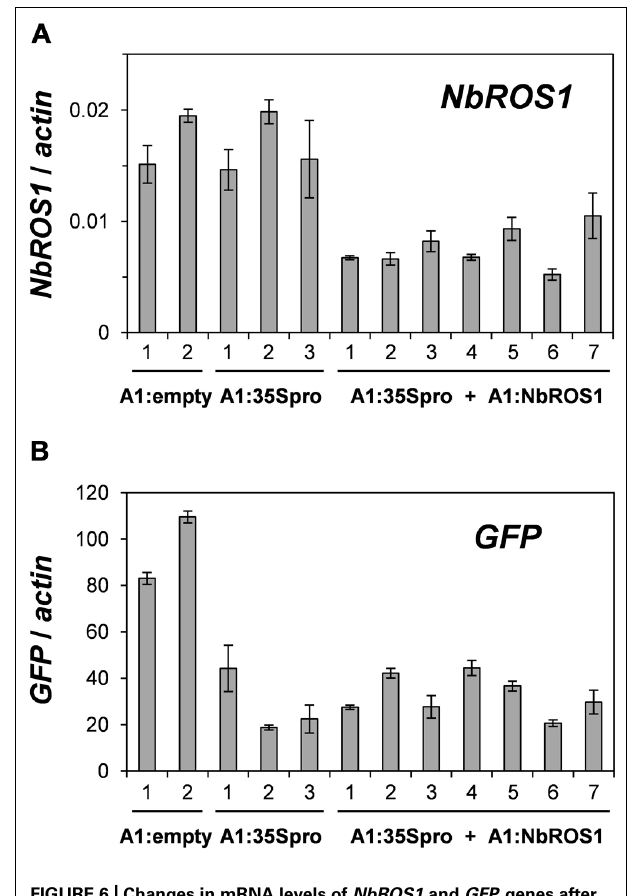
FIGURE 6 | Changes in mRNA levels of NbROS1 and GFP genes after infection with CMVs containing a portion of CaMV 35S promoter or NbROS1 . The mRNA levels of NbROS1 (A) and GFP (B) were analyzed in plants infected with A1:empty, A1:35Spro, or both A1:35Spro and A1:NbROS1. For these plants, data obtained from 2, 3, and 7 individual plants, respectively, are shown.The mRNA levels were assessed relative to the actin mRNA level in leaf tissues at 18 DPI. Data are means and standard errors obtained from three